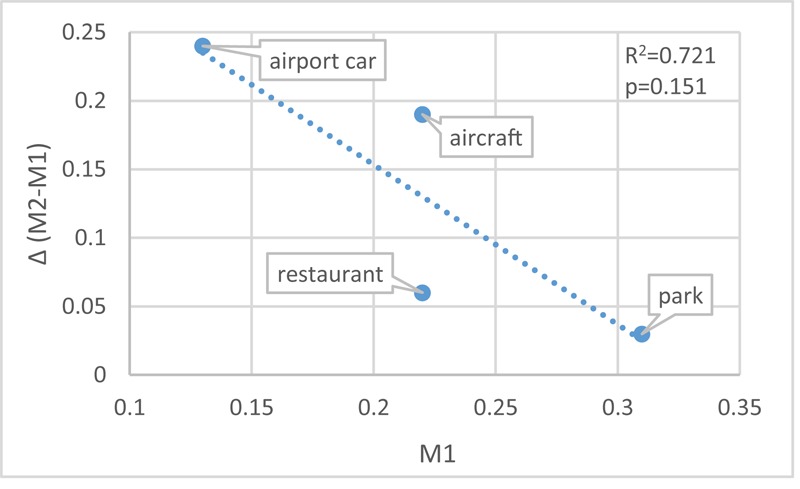
The correlation between M1 and Δ (M2-M1).